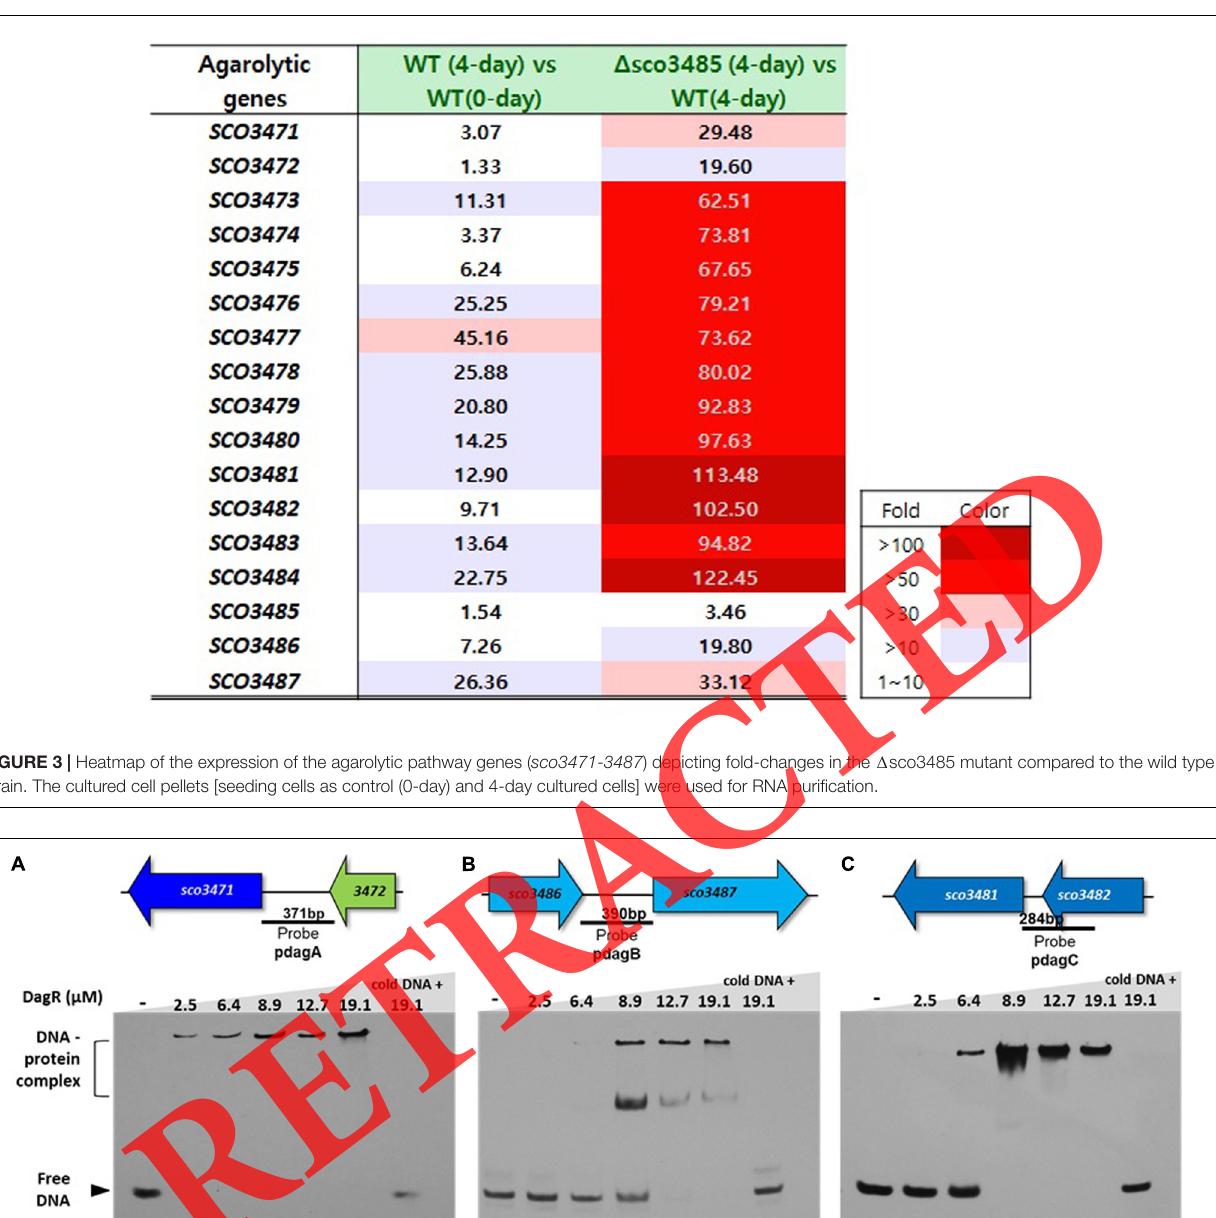
FIGURE 4 | In vitro binding of DagR to the upstream regions of the three agarase genes, dagA , dagB , and dagC . EMSA was carried out with the purified His-tagged DagR protein. The DNA probes used were the upstream regions of dagA (pdagA) (A) , dagB (pdagB) (B) , and dagC (pdagC) (C) . Each 20- µ L binding reaction mixture, containing the biotinylated DNA probe at 1 nM and the DagR protein at various concentrations (0–19.1 µ M), was subjected to electrophoresis on a 6% polyacrylamide gel. Cold, unlabeled